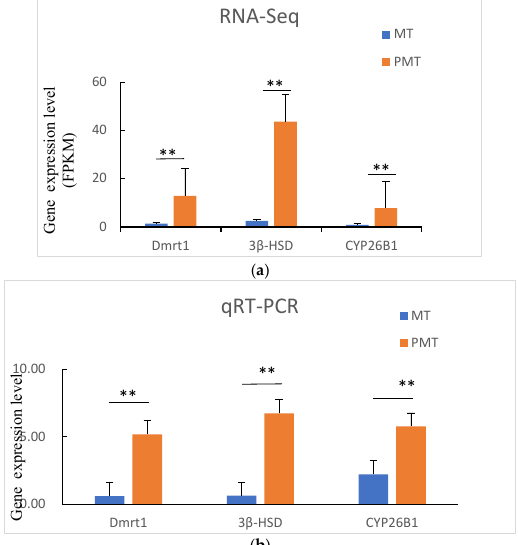
Figure 5. Validation of RNA-Seq results using RT–qPCR. The transcript expression levels of the selected genes were normalized to that of the β -actin gene. ( a ) The relative expression level of DEGs in MT-vs.-PMT groups determined by RNA-seq. ( b ) The relative expression level of DEGs in MT-vs.-PMT groups determined by qRT-PCR. ** p < 0.01.